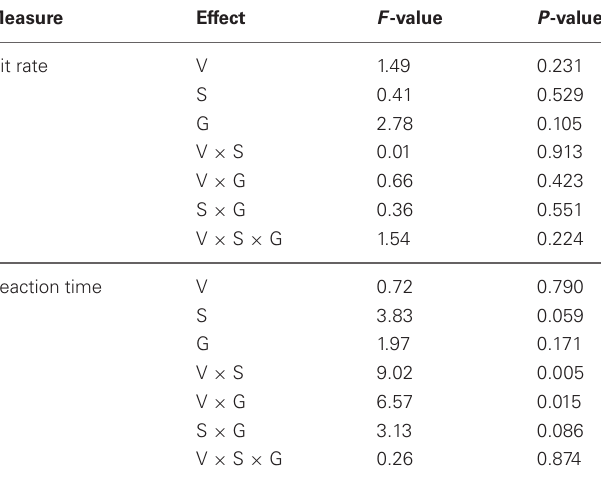
Table 2 | Modulation of hit rate and reaction time.